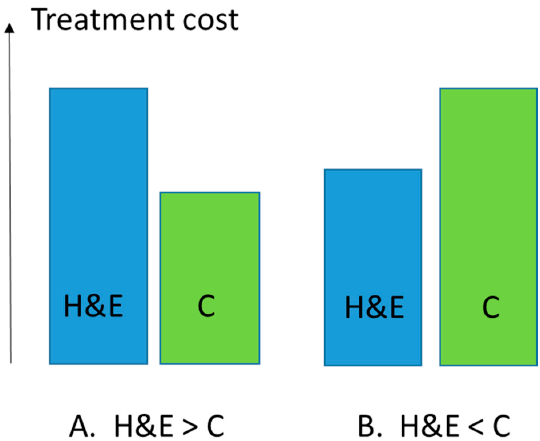
Figure 2. For each ASR operation there will be a cost associated with water quality management to meet health and environmental requirements for groundwater and recovered water and for treating water to avoid clogging. Case A illustrates where treatment to meet health and environmental requirements is more onerous than that required to manage clogging. For Case B, treatment to manage clogging is the more onerous cost and, hence, may influence viability of ASR.